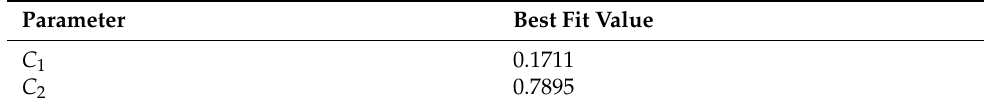
Table 2. Fit values of the diffusion – porosity correlation.